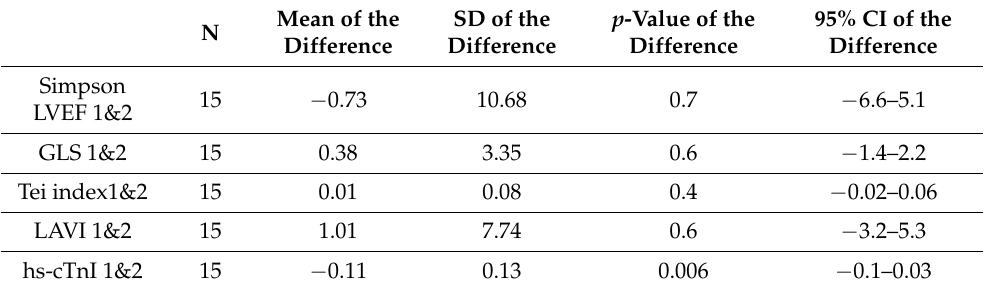
SD, Standard deviation; CI, Confidence interval; LVEF, left ventricular ejection fraction; GLS, Global longitudinal strain; LAVI, Left atrial volume index; hs-cTnI, high-sensitivity cardiac troponin